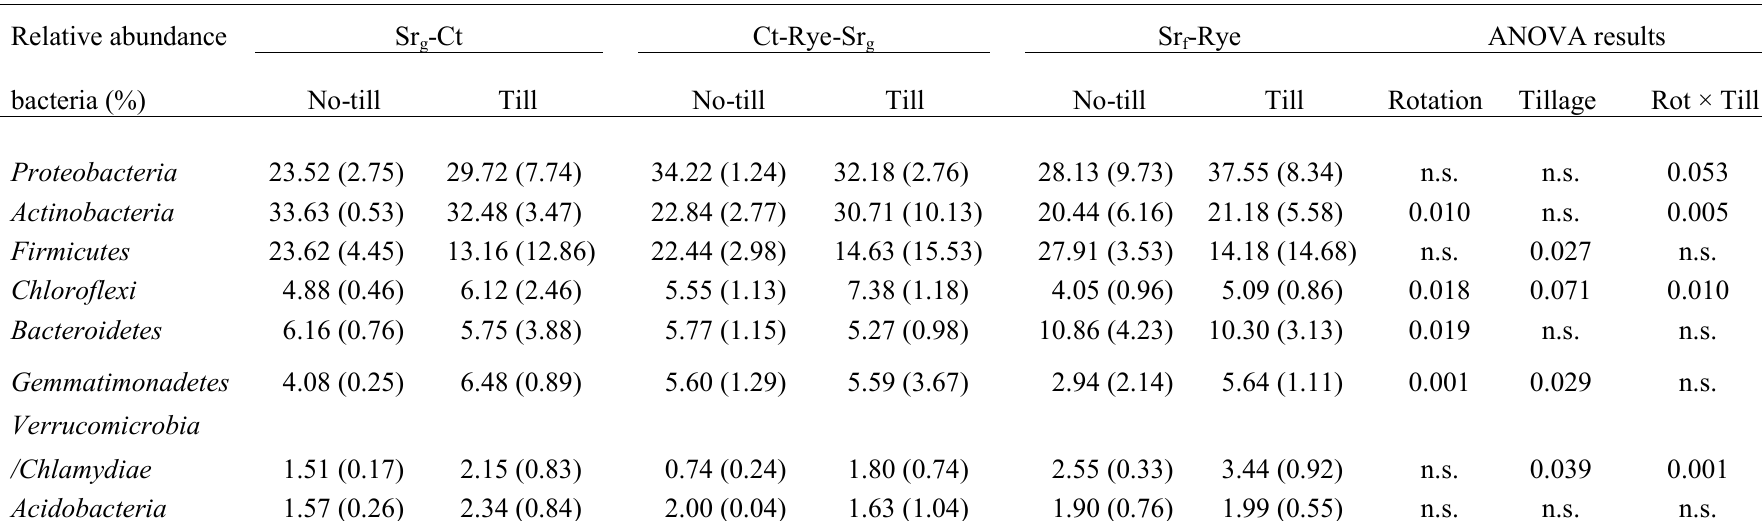
Table 3. Bacterial phyla distribution as affected by dryland cropping systems and tillage in a semiarid sandy soil.